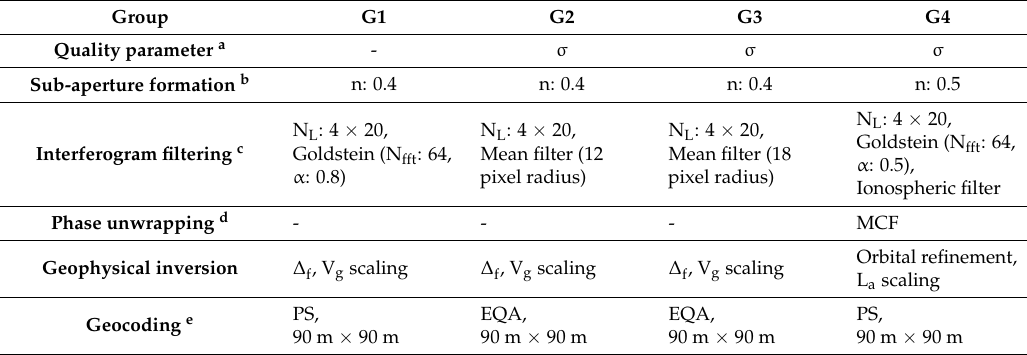
Table 5. Task 2 main processing